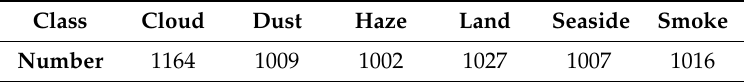
Table 2. Number of images for each class in the USTC_SmokeRS